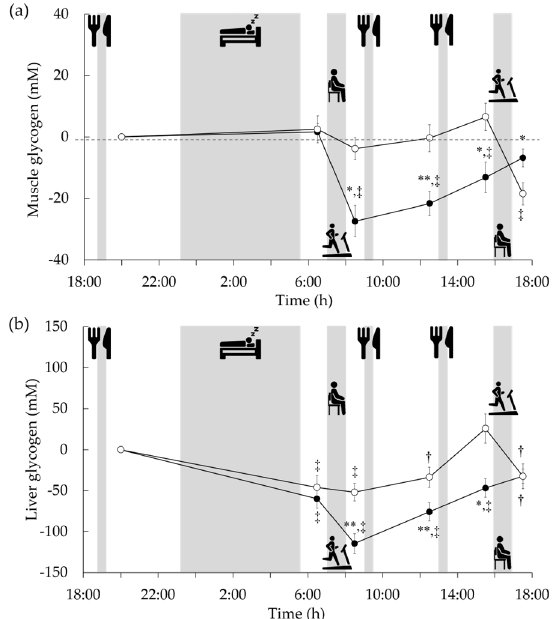
Figure 8. Changes from baseline (after supper, before bedtime) in muscle ( a ) and liver ( b ) glycogen stores after exercise in postabsorptive (closed circle) and postprandial (open circle) conditions [60]. Values are shown as mean ± standard error for the nine participants. * p < 0.05 vs. postprandial trial. ** p < 0.01 vs. postprandial trial. † p < 0.05 vs. baseline. ‡ p < 0.01 vs. baseline.